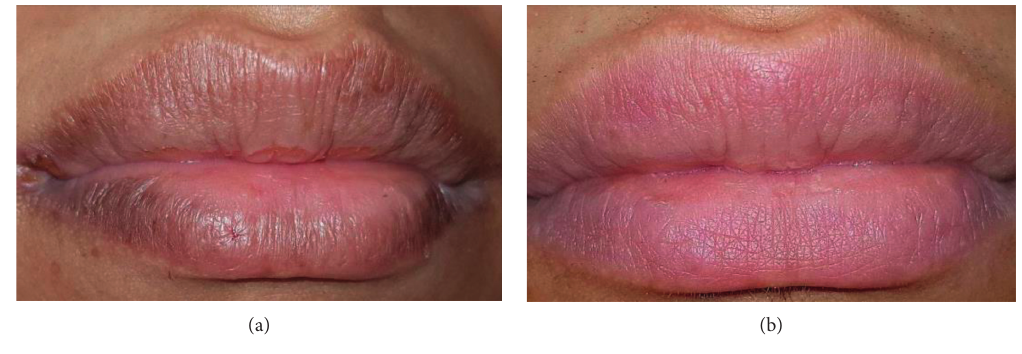
Figure 15: (a) Before and (b) 14 days after the last session. Table 4: Comparing Er, Cr:YSGG to Q-switched Nd :YAG 1064nm laser and Q-switched Nd :YAG 532nm laser in the treatment of hyperpigmented lips (comparison between different